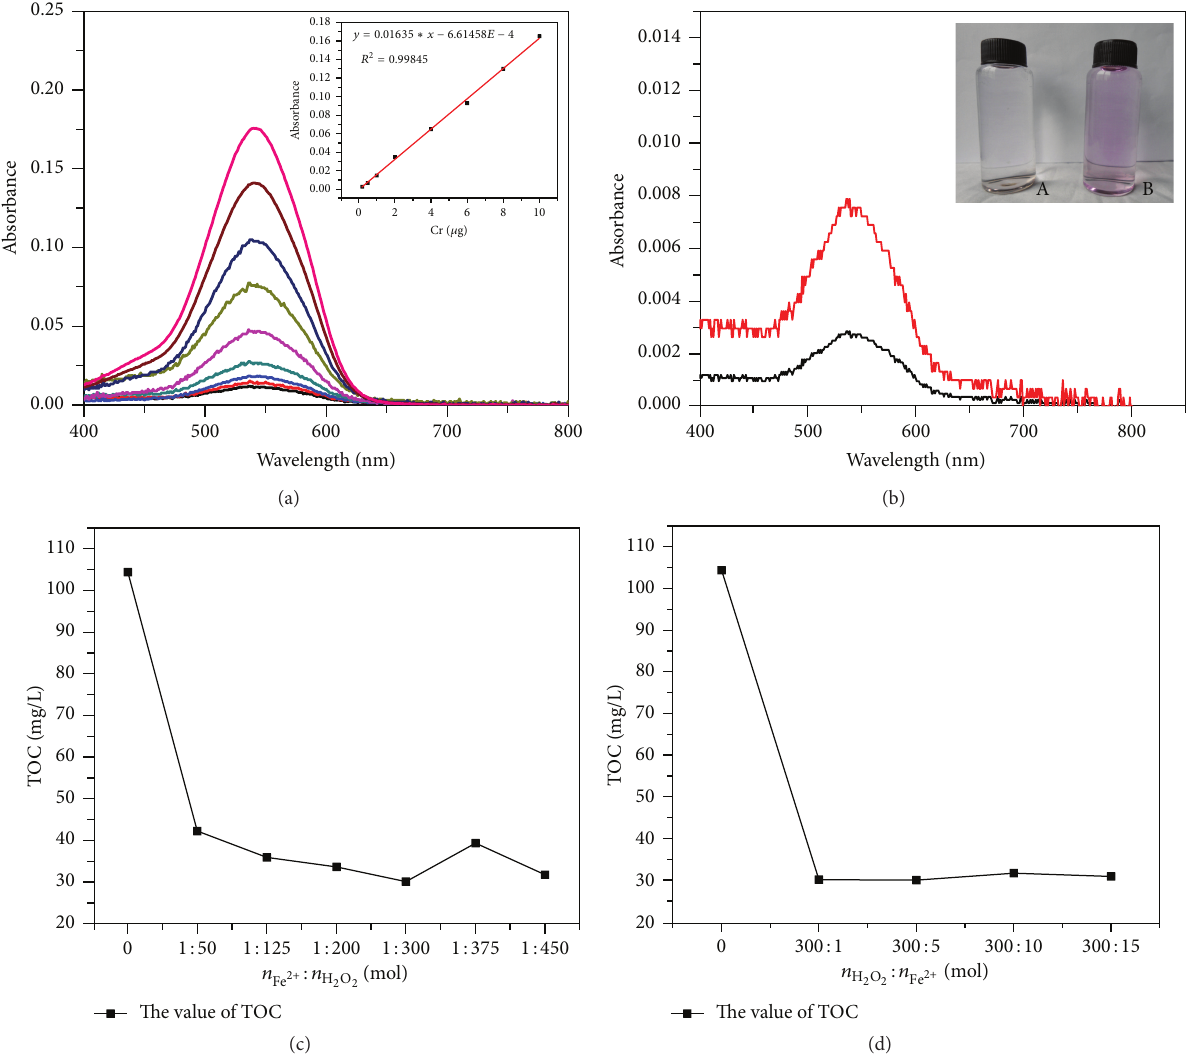
Figure 1: The curve of absorbance corresponding to the wavelength and the change of TOC with the amount of Fenton